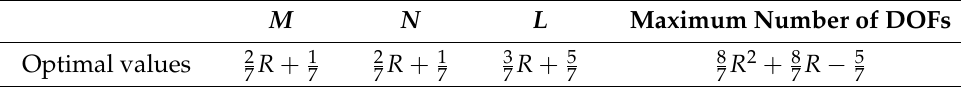
Table 1. The optimal choice of M , N , and L and maximum number of DOFs.